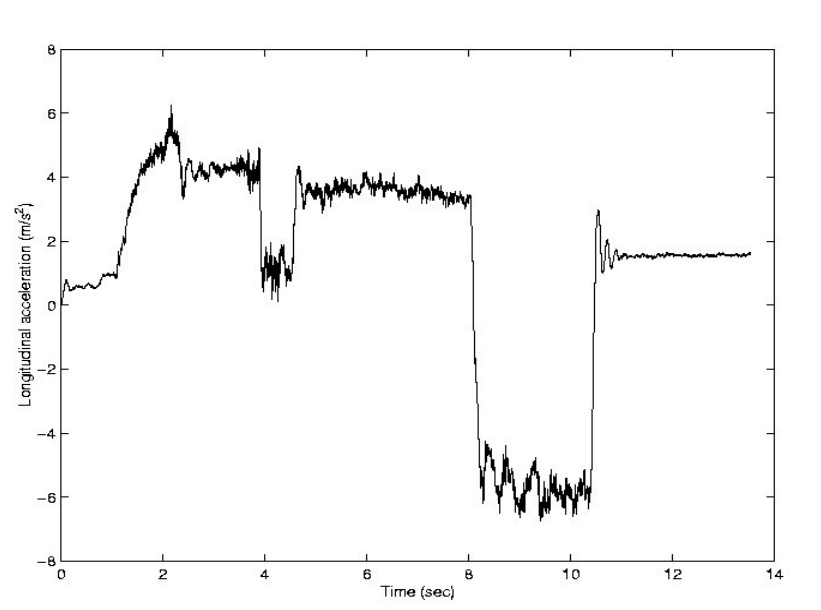
Figure 9. Estimated value of the longitudinal acceleration.